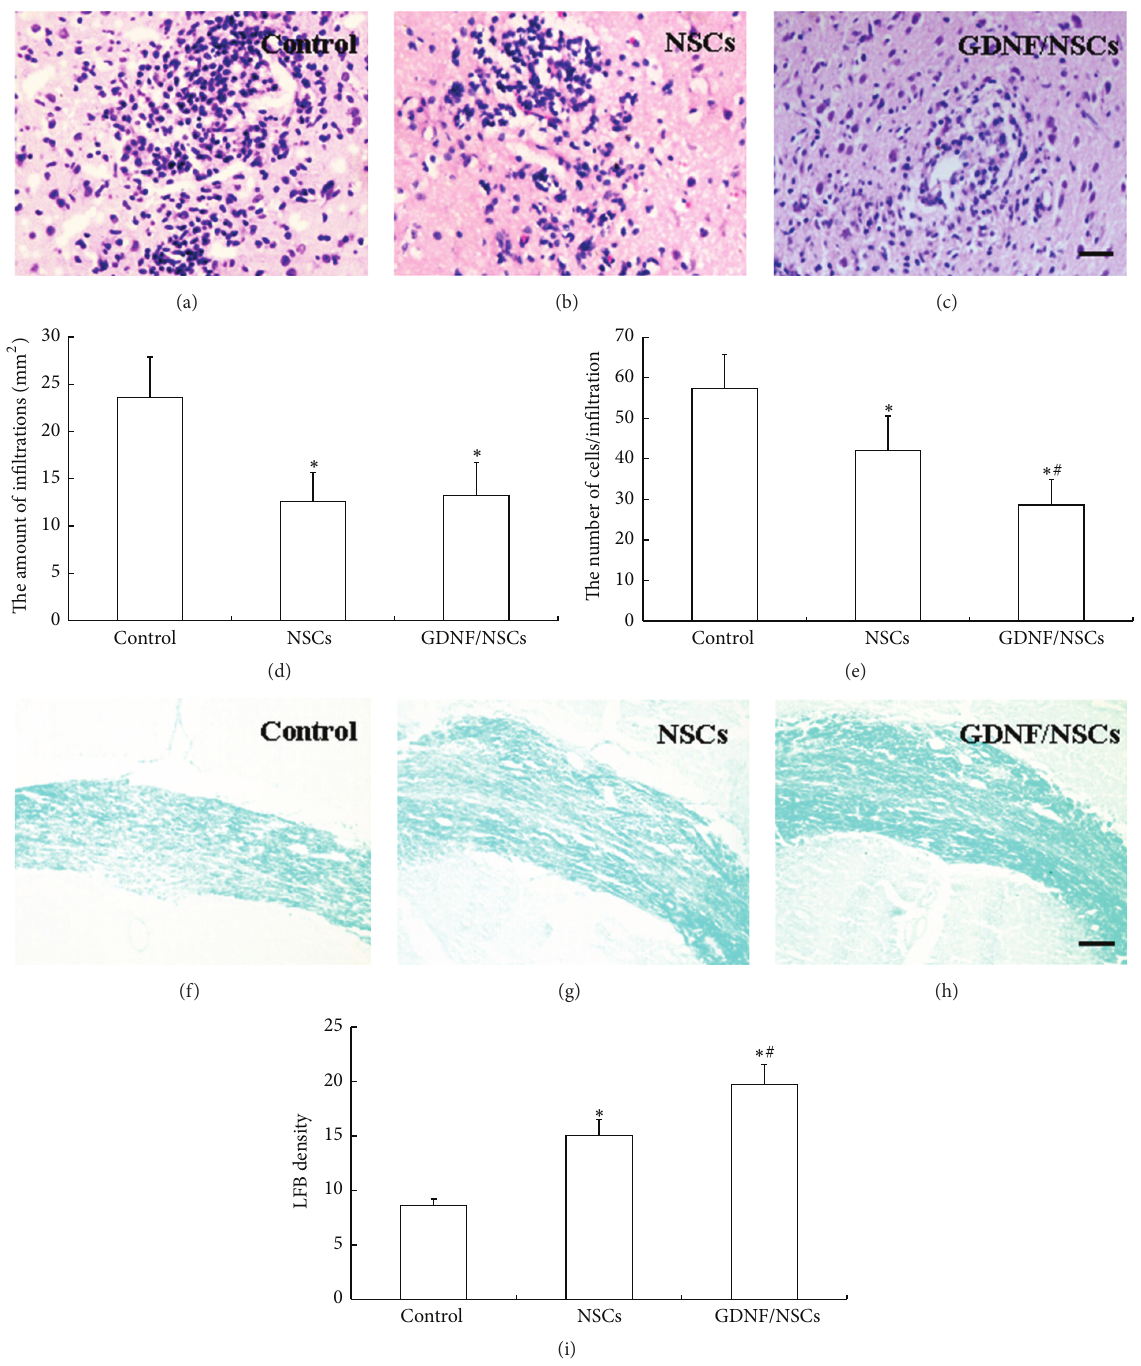
Figure 3: Attenuated inflammation and more myelin sheath in GDNF/NSCs compared to NSCs in EAE rats. (a–c) HE staining showed inflammatory infiltrates of the cerebral parenchyma in control, NSCs, and GDNF/NSCs groups, respectively. The control group showed much more infiltration with inflammatory cells. The transplanted groups displayed a reduction in the amount and size of the inflammatory infiltration, especially for the GDNF/NSC transplanted group. (d) Quantitative analysis of the amount of infiltration per mm 2 (mean ± SD, 𝑛 = 5 ). ∗ Compared with control group, 𝑃 < 0.05 . (e) Quantitative analysis of the number of cells per infiltration (mean ± SD, 𝑛 = 5 ). ∗ Compared with control group, 𝑃 < 0.05 . # Compared with NSCs group, 𝑃 < 0.05 . (f–h) LFB staining showed myelin sheath of the corpus callosumincontrol,NSCs,andGDNF/NSCsgroups,respectively.Controlgroupshowedmarkedsparserandthinnermyelinsheathcompared with transplanted groups. In particular, GDNF/NSCs groups displayed more myelinated fibers than NSCs group. (i) Quantitative analysis of LFB density (mean ± SD, 𝑛 = 5 ). ∗ Compared with control group, 𝑃 < 0.05 ; # compared with NSCs group, 𝑃 < 0.05 . Bar = 100 𝜇